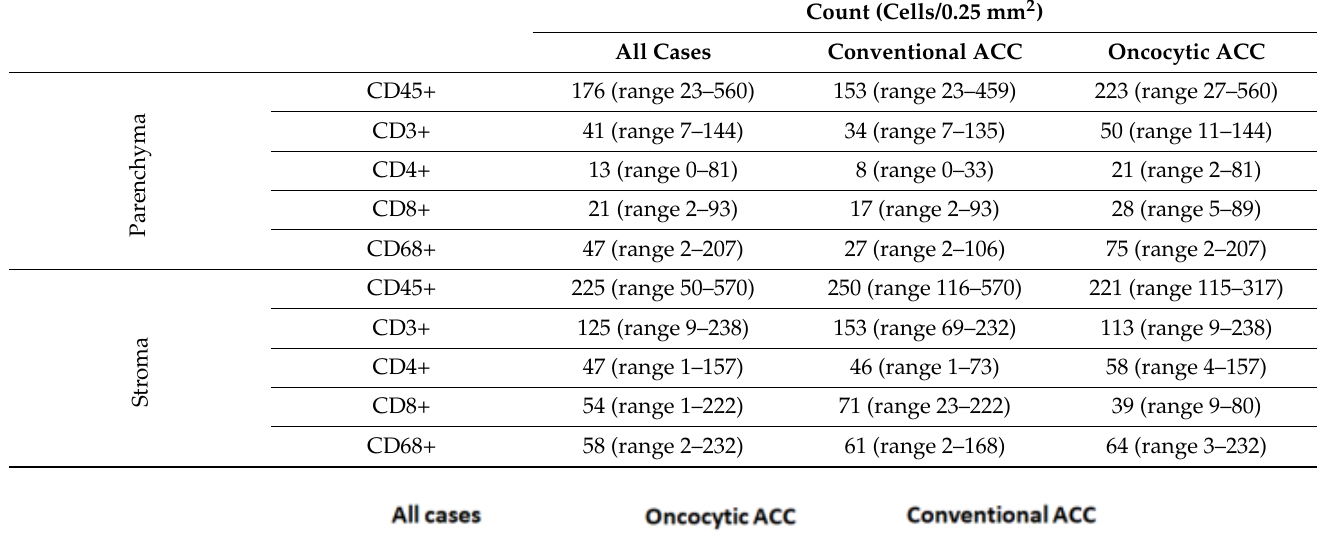
Table 1. Presence of different immune cell subtypes in tumor parenchyma and stroma of cases from ERC cohort.